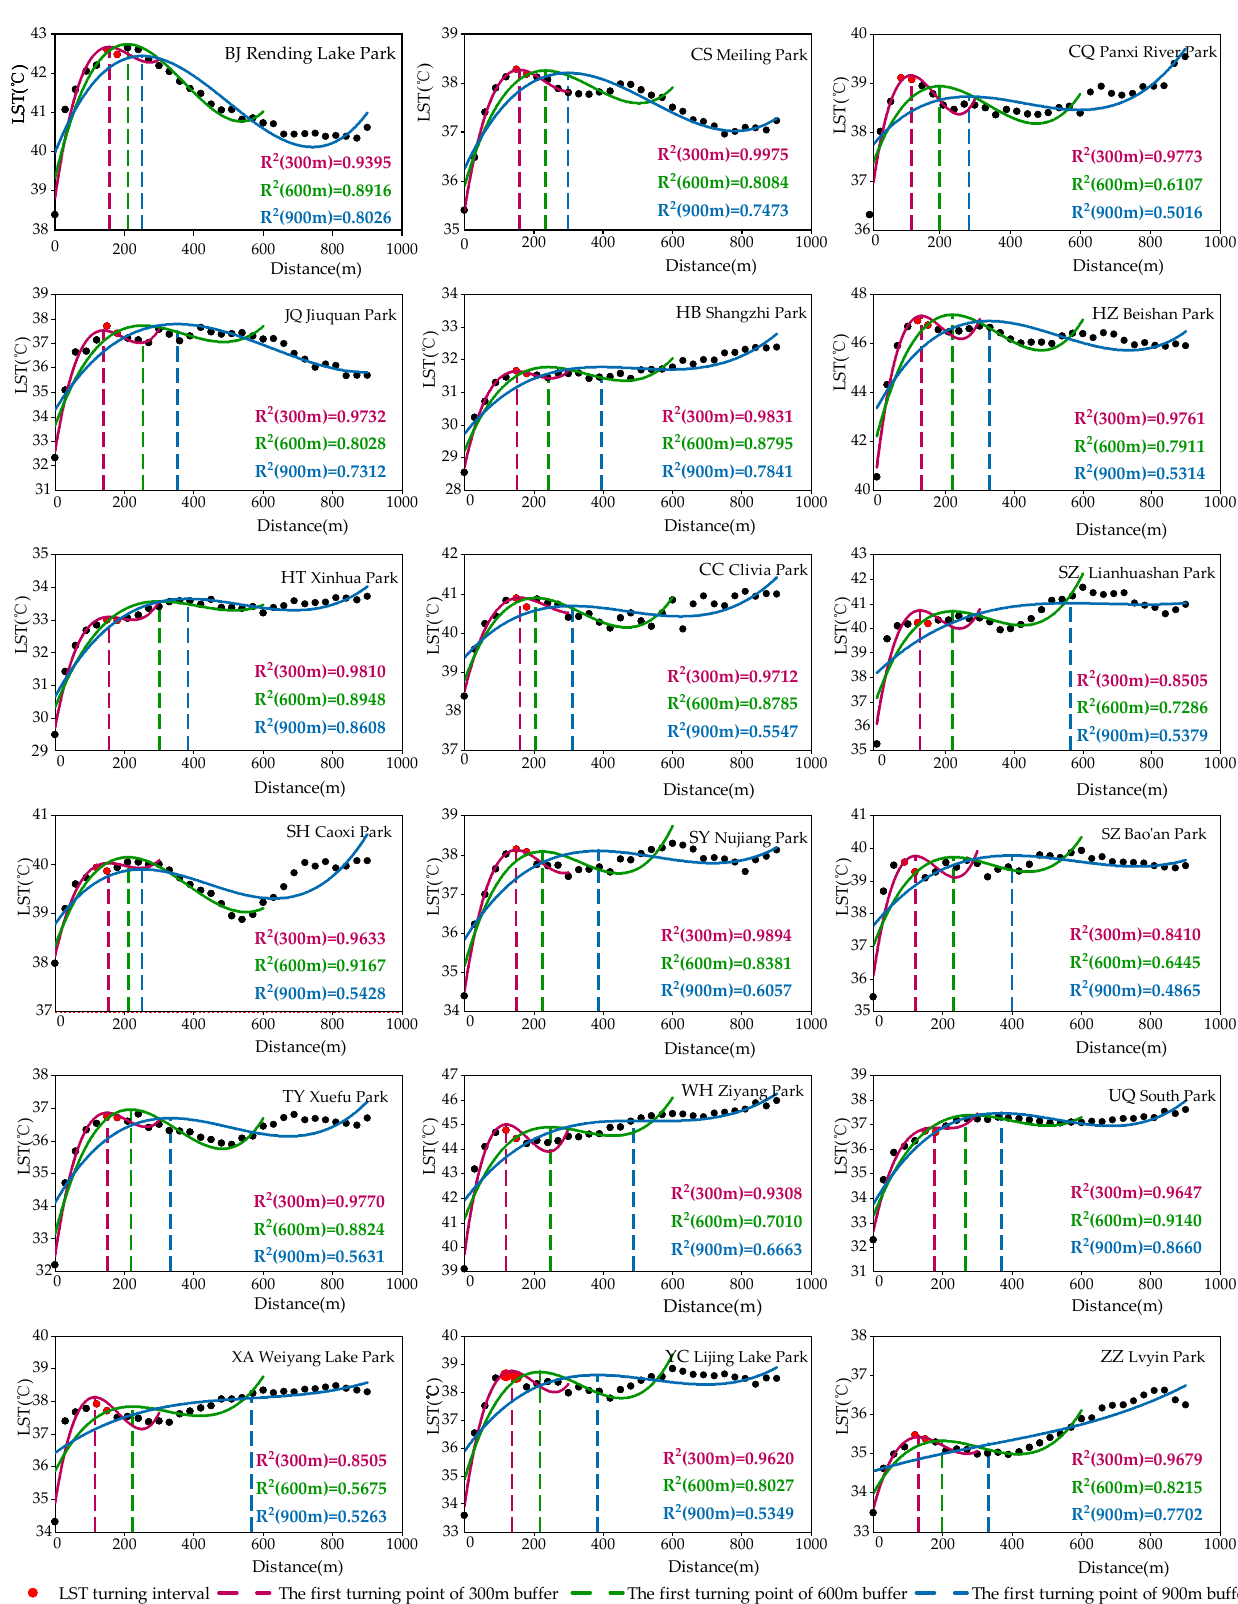
Figure 8. Impact of buffer zone width on cooling effect in randomly selected urban parks.